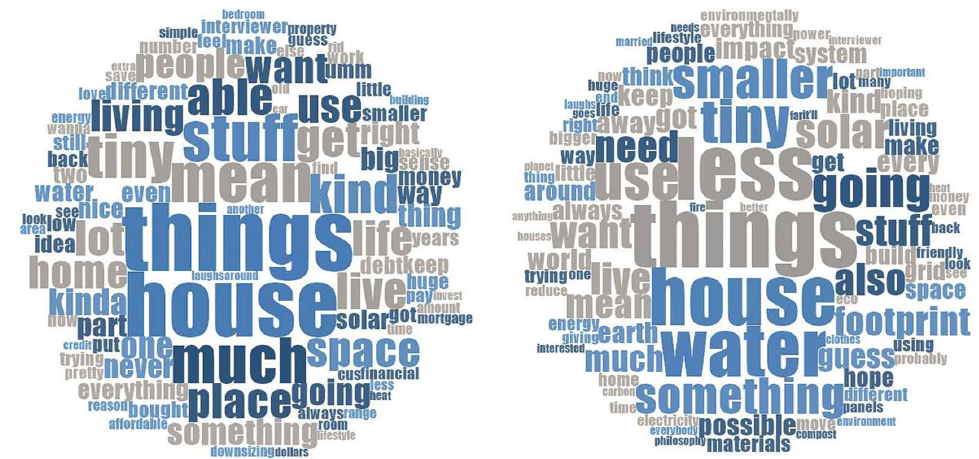
Figure 5. Word clouds for Motivator 4. The left cloud represents most frequent responses in the personal motives’ category. The right cloud captures word frequencies for the mixed motive category.